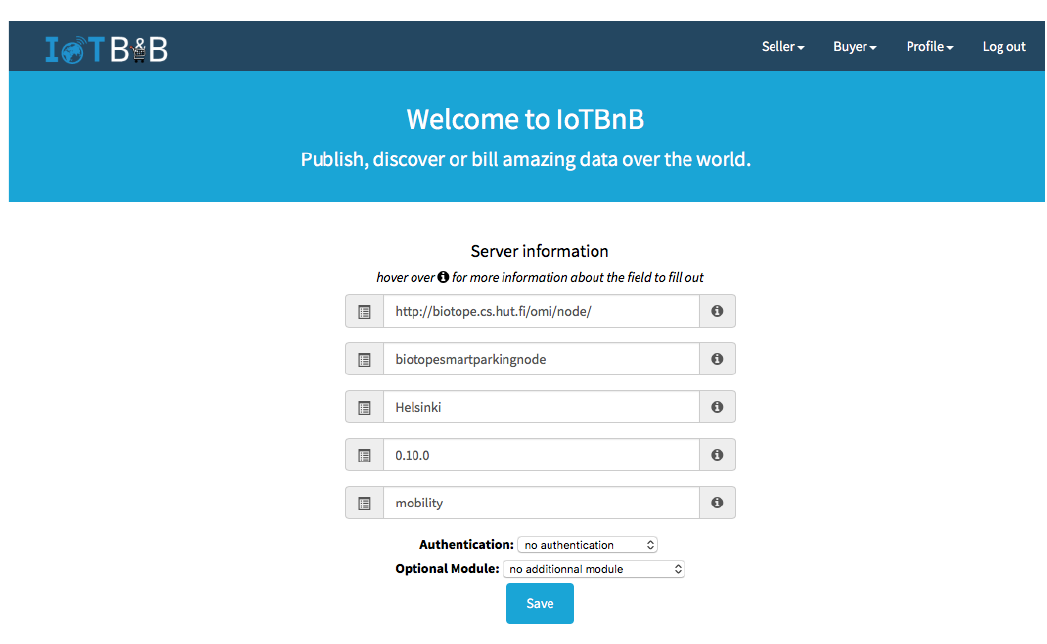
Figure 6. Server information to be filled out by the O-MI owners.